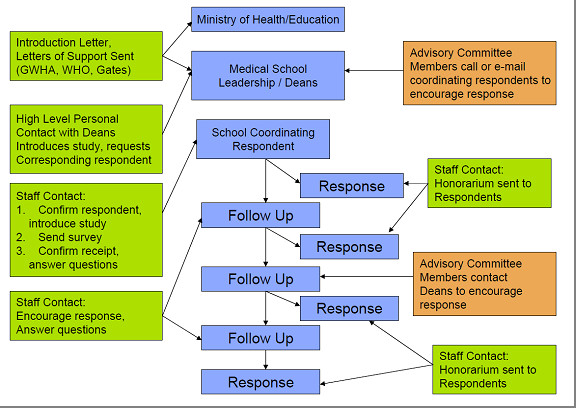
SAMSS survey plan.